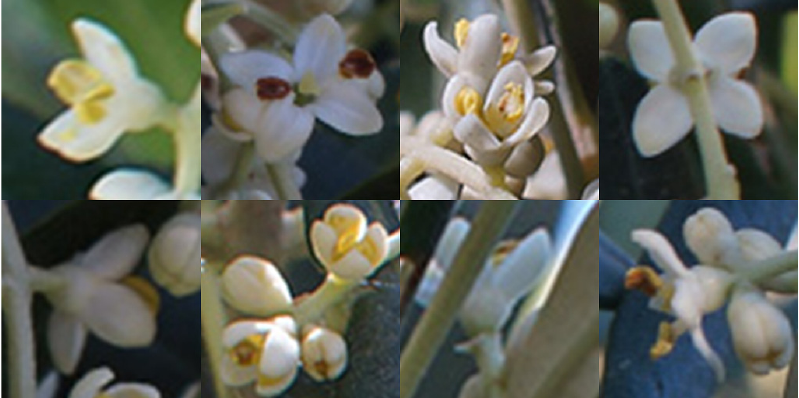
Figure 3. Illustration of the variations of open flowers.